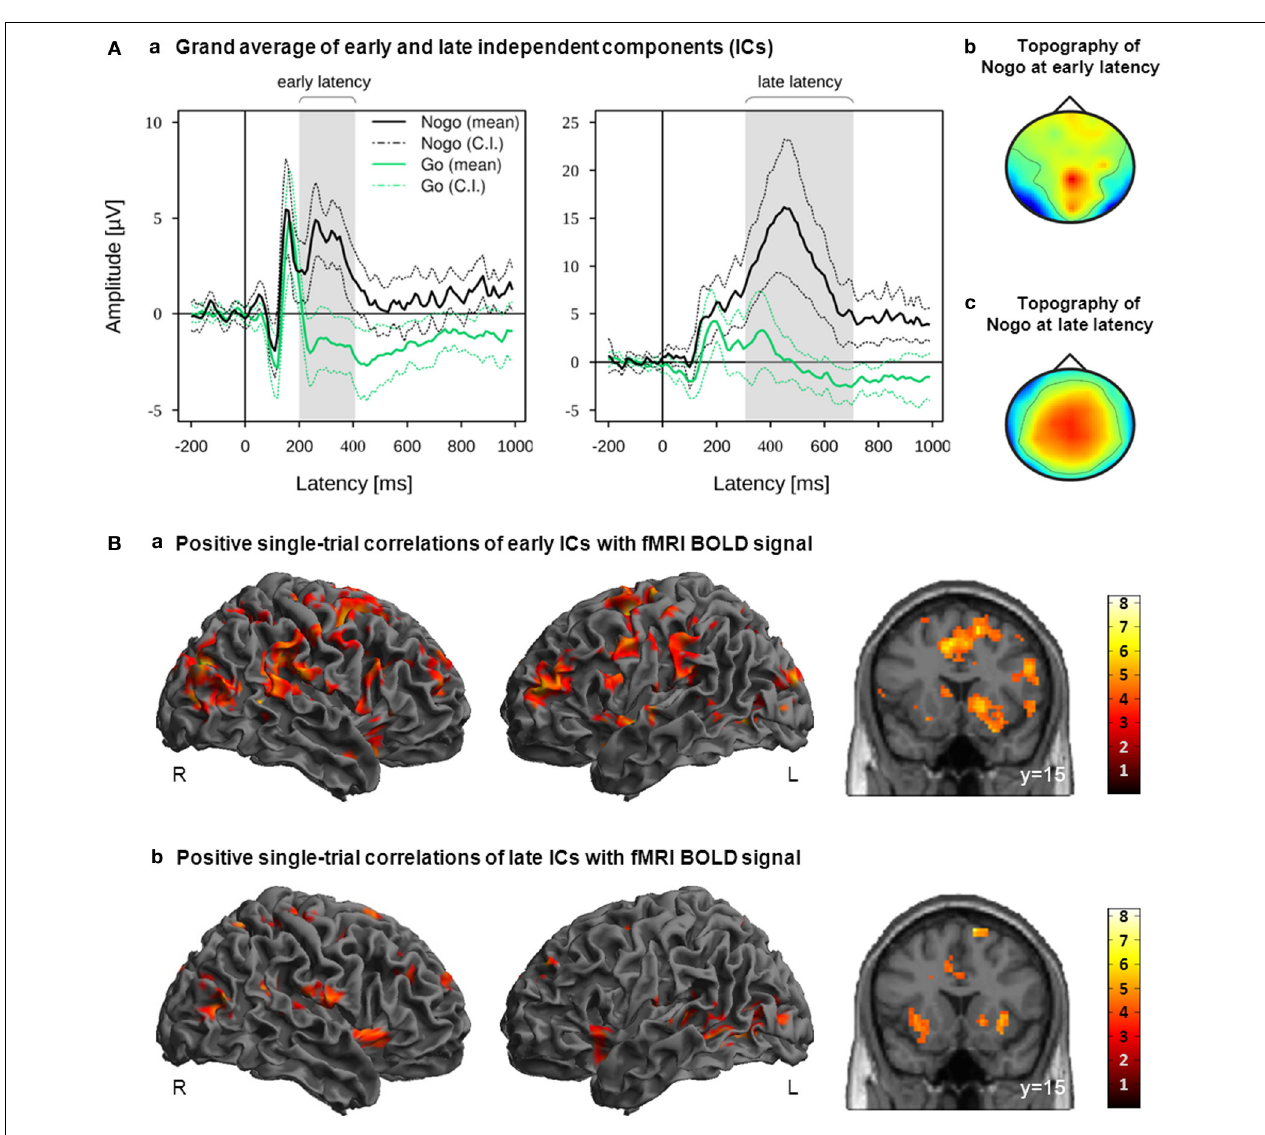
FIGURE 3 | (A) IC activation grand averages (a) and grand mean topographies (b,c) of all participants ICs which were classified as reliably Nogo-related within the early latency range or late latency range. Mean and 95% confidence interval (CI) of Nogo (black lines) and Go (green lines) are displayed in solid and dotted lines, respectively; gray bars indicate the early and late latency ranges on the group level. (B) Activation maps displaying the